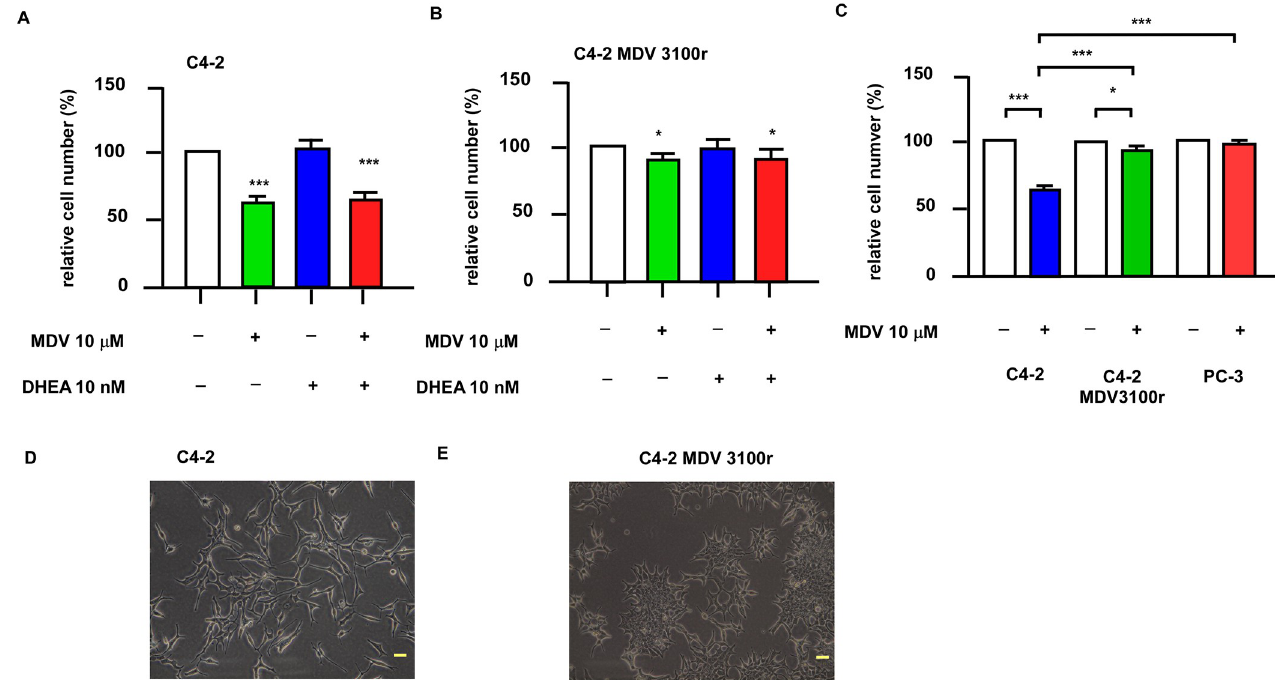
Fig 1. Characterizing the response of enzalutamide-resistant C4-2 MDV3100r and PC-3 cell lines to treatment of GRT and DHEA. The enzalutamide- resistant C4-2 MDV3100r cell lines was derived from parental LNCaP C4-2 by culturing the cell in medium containing 10 μ M enzalutamide and 20 nM DHEA for at least 3 months. The effect of enzalutamide (MDV-3100) treatment in the presence or absence of DHEA on the proliferation of C4-2 (A) and C4-2 MDV3100r (B) for 96 h was examined by Hoechst 33258 proliferation assay. (C) The proliferation of C4-2, C4-2 MDV3100r, and PC-3 under 0 or 10 μ M MDV for 96 h was examined by proliferation assay. The morphology of C4-2 and C4-2 MDV3100r were show in (D) and (E) under light microscope. The magnification of the microscope is 1,000X and the yellow scale bar represented 100 μ m.